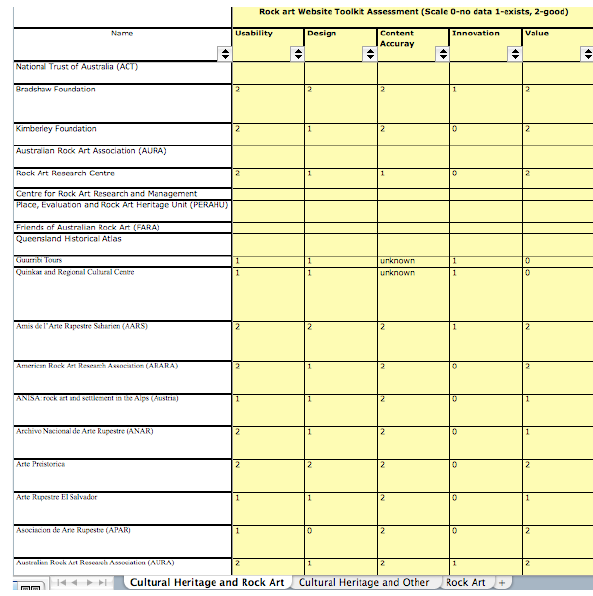
Figure 2. Analysis of McNeil & Taçon List of Rock Art Website Resource Kit shows inconsistency and inadequate data